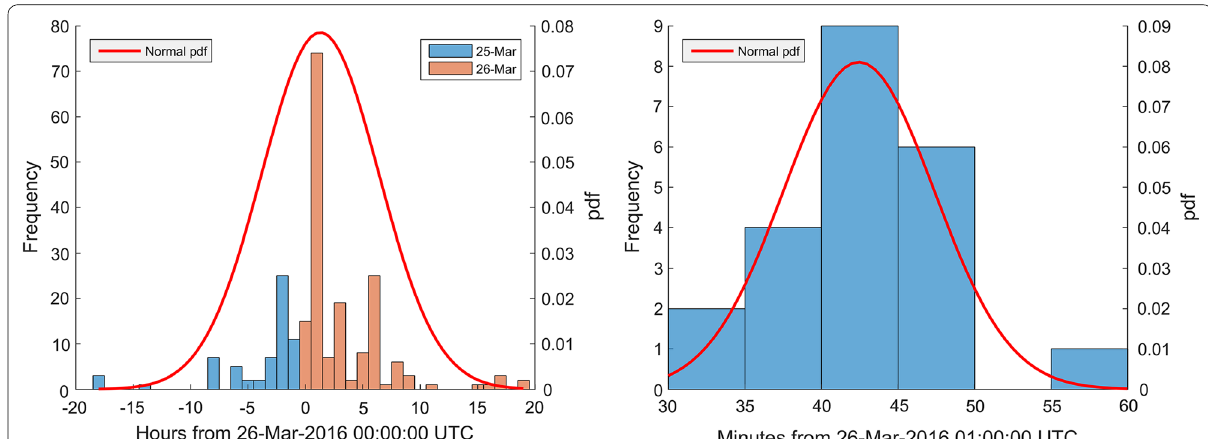
Fig. 1 Histogram and probability density function plot for the estimated breakup event times around 26 March 2016 00:00:00 UTC ( left ). Histogram and probability density function plot for the estimated breakup event times during 01:00–02:00 UTC on 26 March 2016 ( right